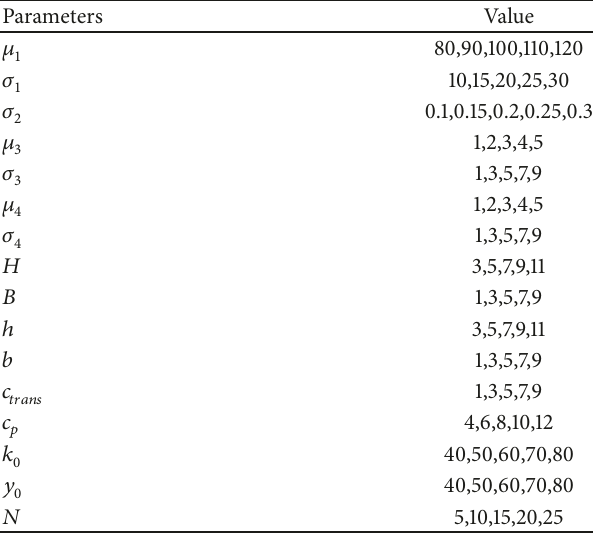
Table 2: Thevalues of important parameters in experiments.